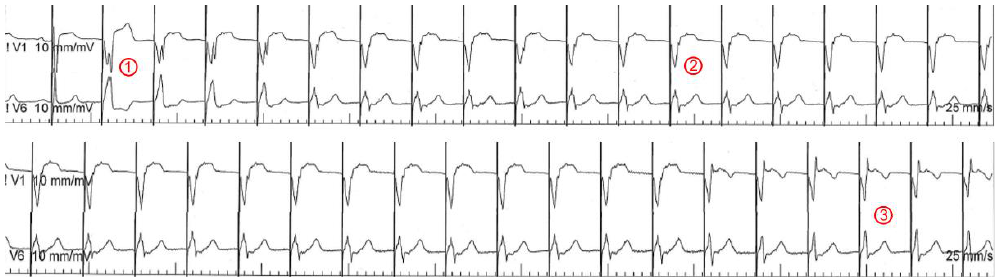
Figure 3. ECG leads V1 and V6 during LBBAP lead implantation. Continuous unipolar pacing is performed from the lead ’s tip. ① A wide QRS reflecting right ventricular septal pacing with a notch near the nadir of the QRS (one of the criteria for a suitable starting position for lead drilling). ② During the drilling process, this notch starts to move towards the end of the QRS in V1 and the QRS duration is shortened (deep septal pacing). ③ Finally , an r’ appears in V1 and the QRS suddenly shortens again significantly, indicating CSP capture.